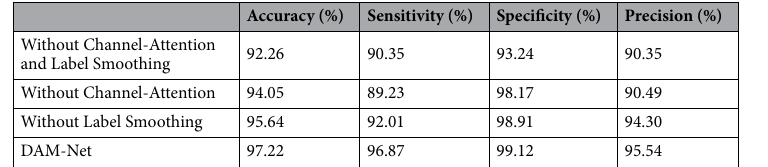
Table 3. Ablation study metrics on full COVIDx